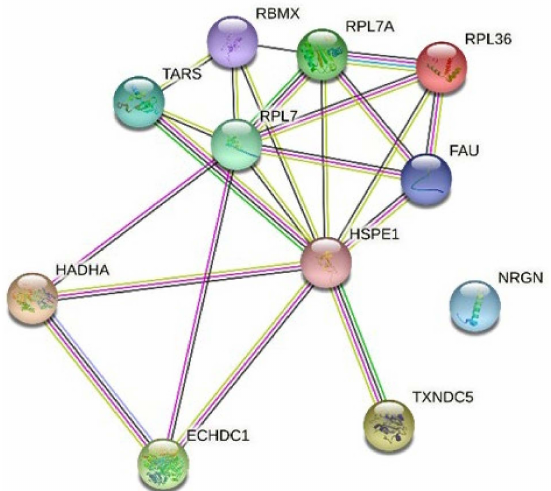
Figure 2. Graphic representation by STRING of the interactions of the identified DAPs. The nodes represent the identified proteins, and the lines represent associations from the different sources: blue from databases, pink from experimental determinations, dark green from predictions due to closeness of genes, yellow from to appearance in documents, and black from